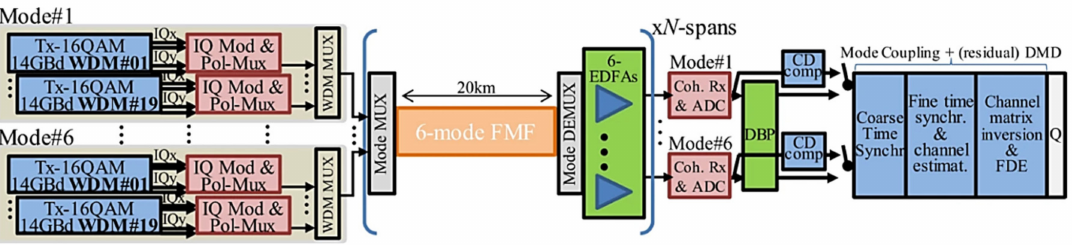
Figure 15. Simulated WDM-MDM system based on new